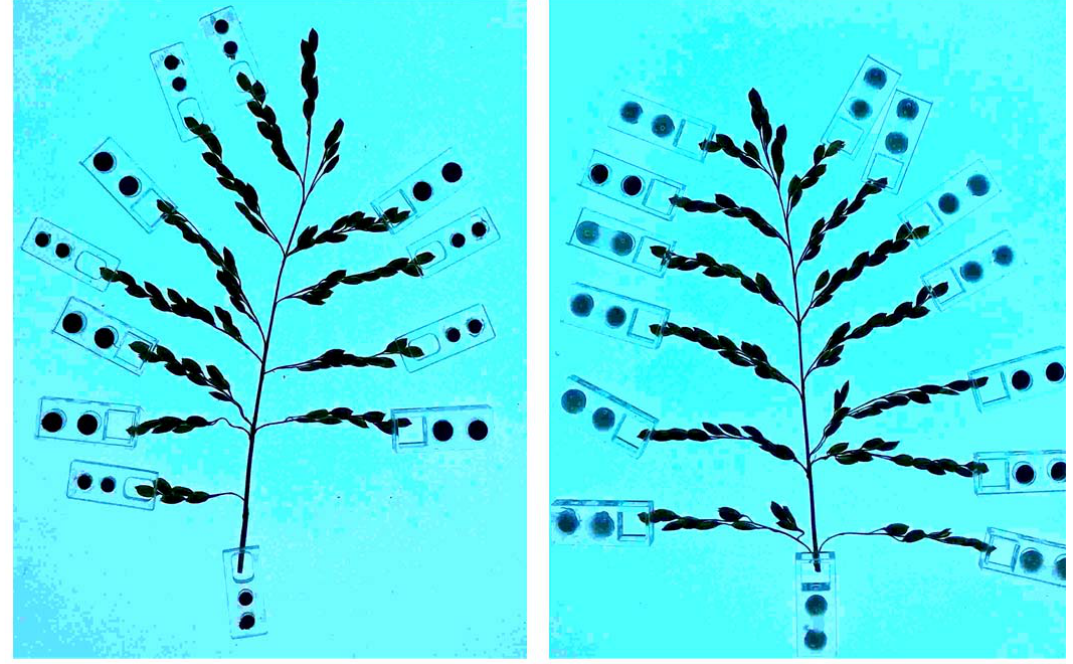
Figure 9. Original pictures of sample A ( left ) and sample B ( right ).